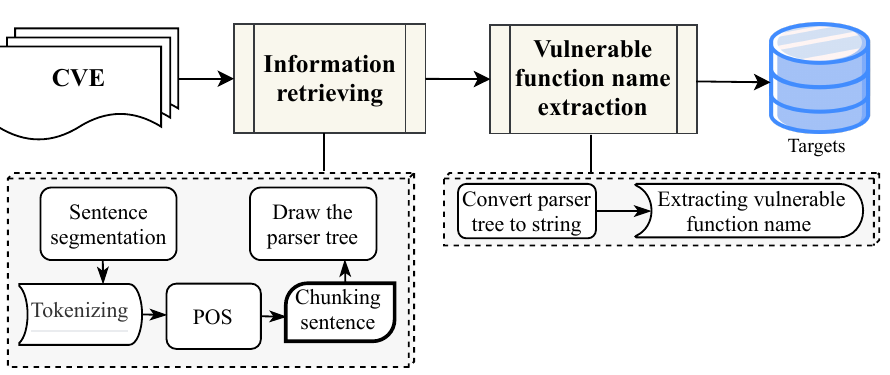
Figure 2. Overall workflow of the bug report